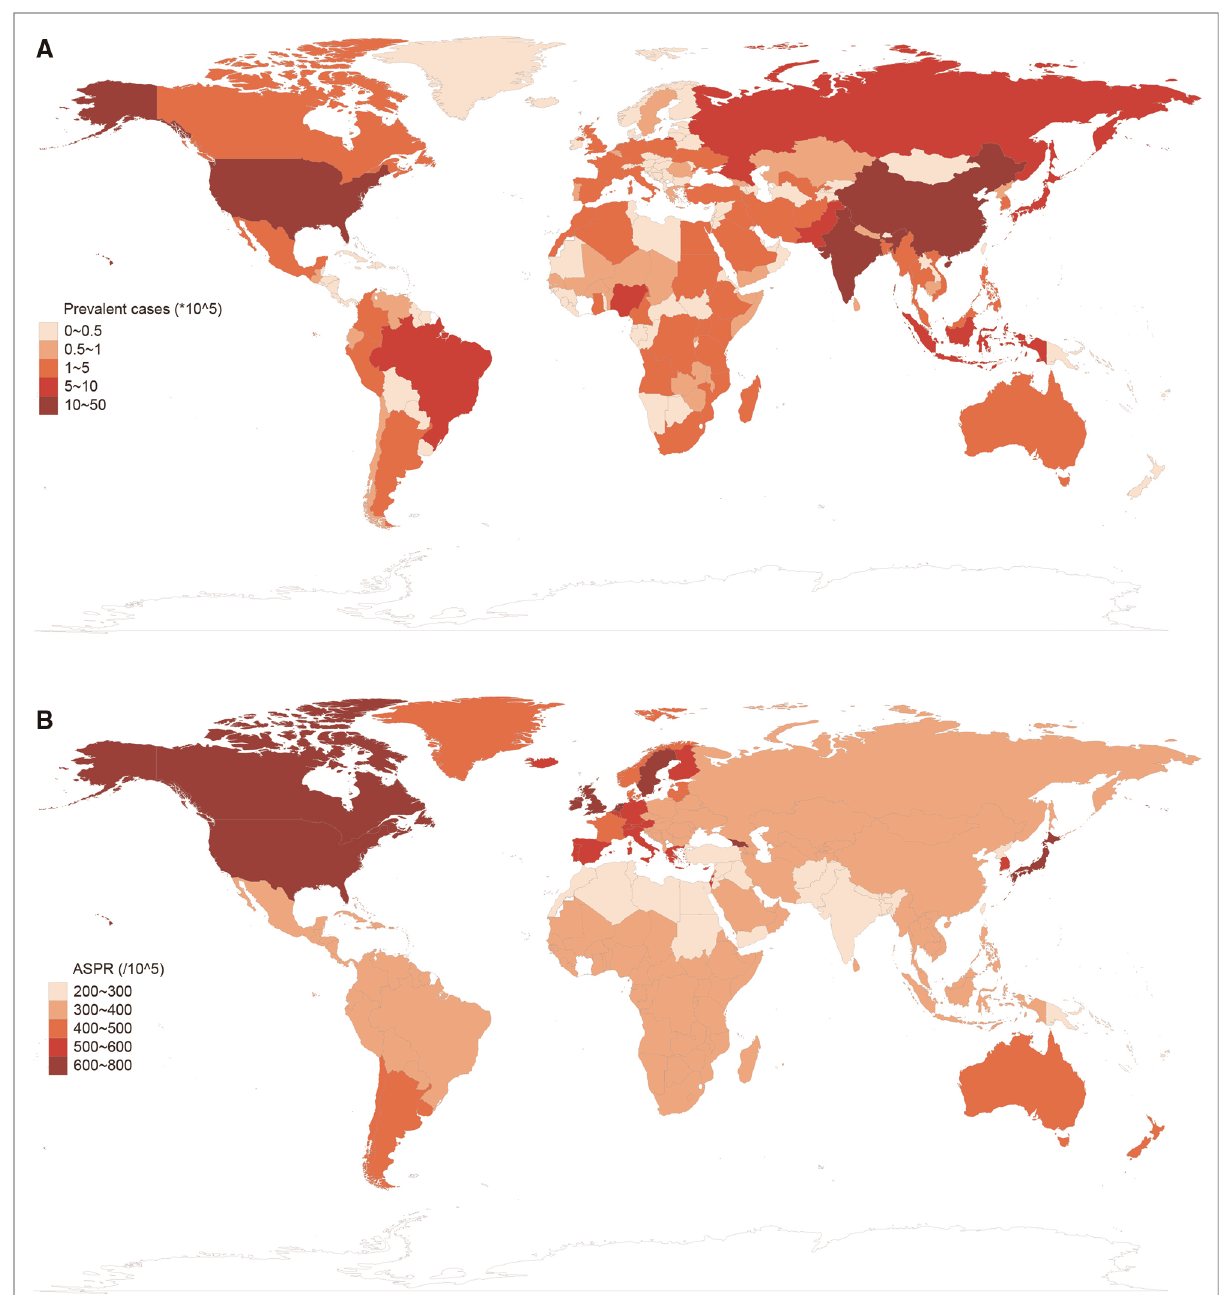
FIGURE 1 Global prevalence of autism spectrum disorders in 2019. ( A ) Prevalent cases of autism spectrum disorders by location for both sexes in 2019. ( B ) Age- standardized prevalence rate (ASPR) of autism spectrum disorders by location for both sexes in